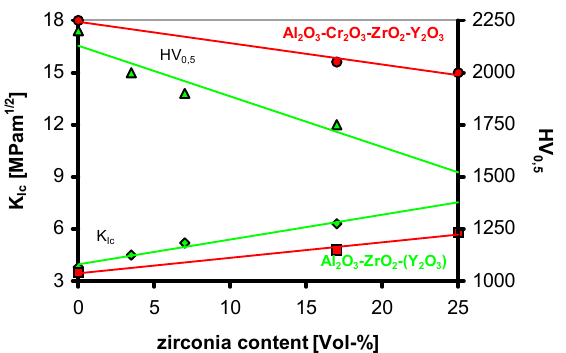
Figure 28. Fracture toughness and hardness within the system Al 2 O 3 -ZrO 2 :Y-Cr 2 O 3 .